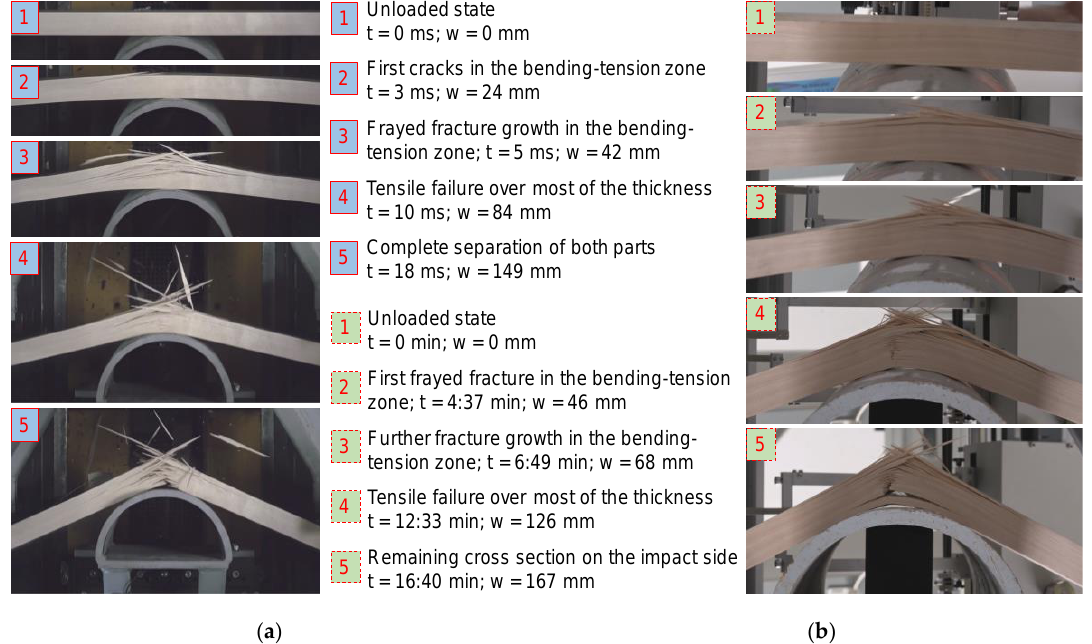
Figure 12. Exemplary loading and failure sequence in a dynamic ( a ) and a quasi-static sample ( b ) in series +30 °C.